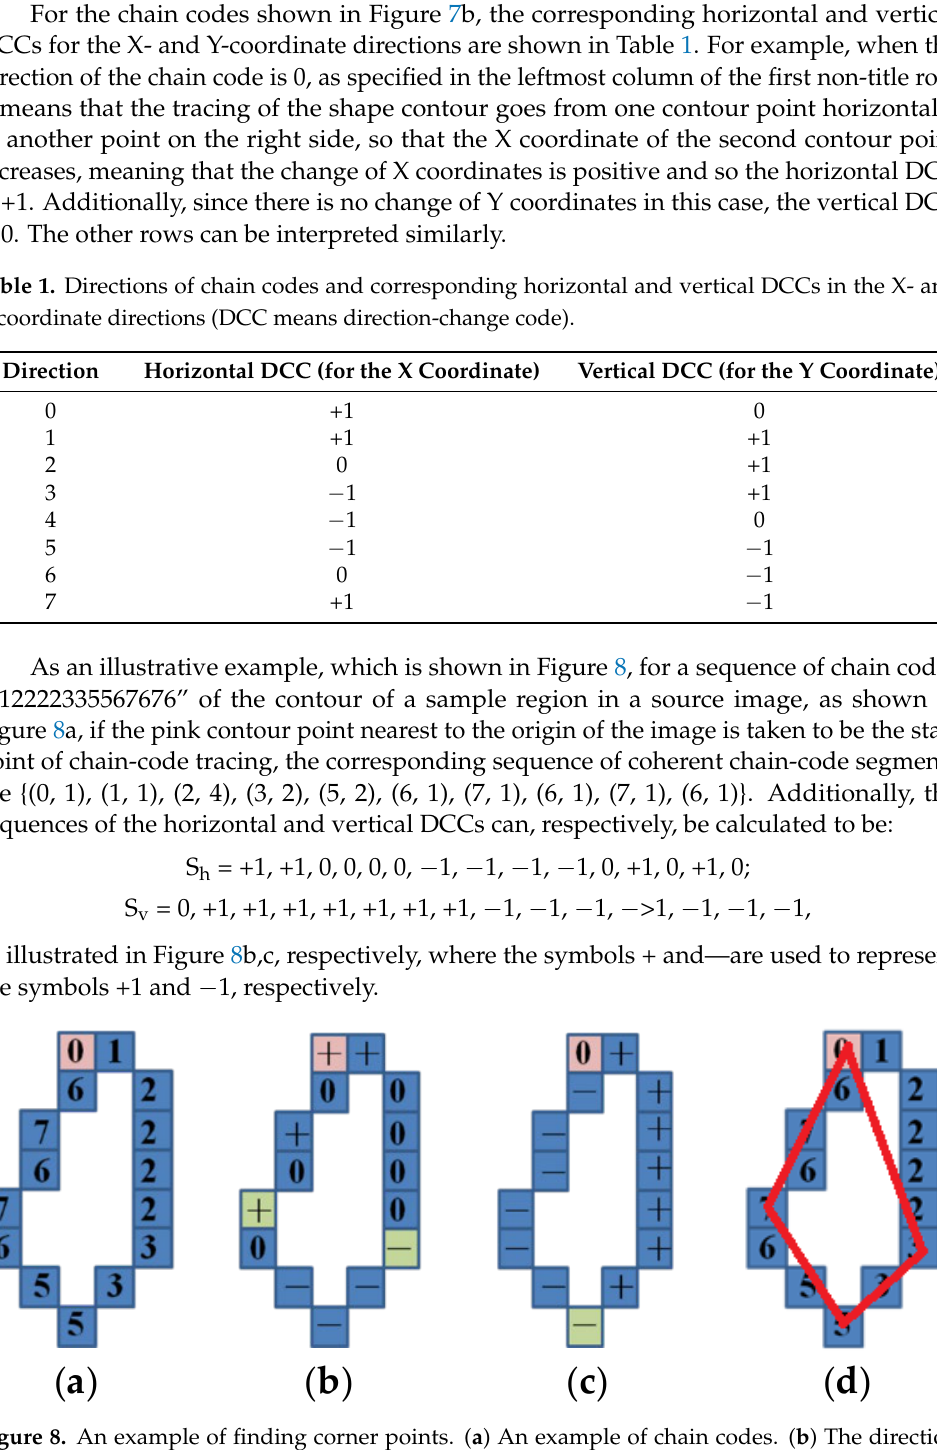
Figure 8. An example of finding corner points. ( a ) An example of chain codes. ( b ) The direction changes in X coordinate. ( c ) The direction changes in Y coordinate. ( d ) The result of connecting all corner points.